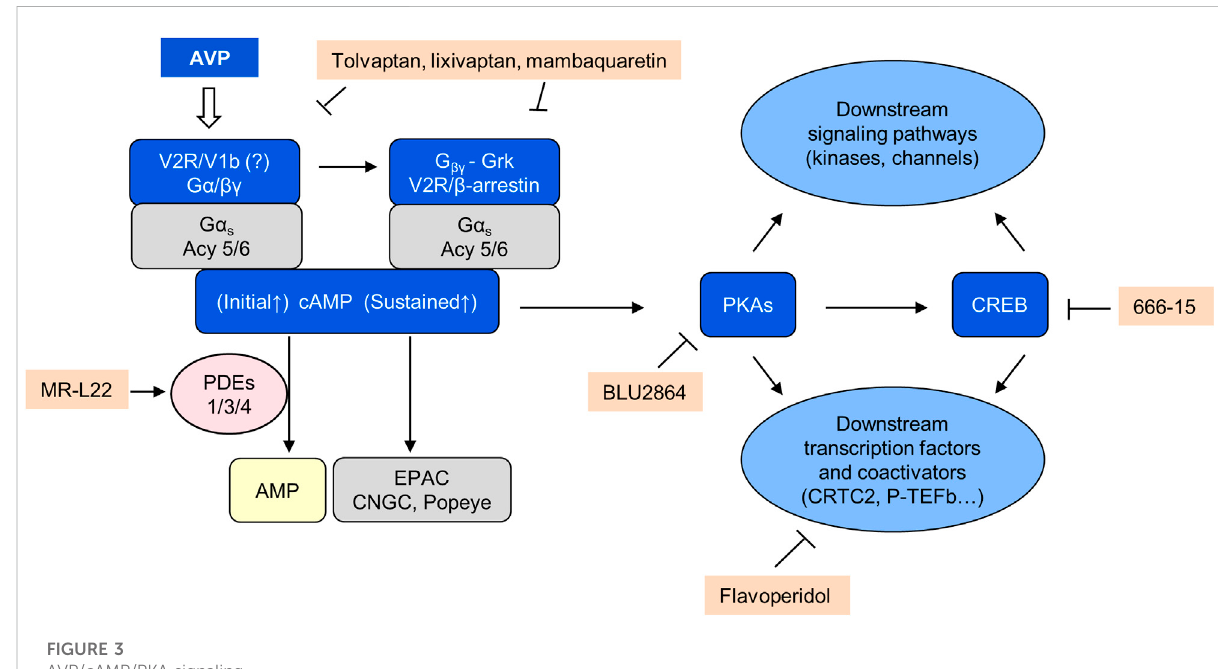
FIGURE 3 AVP/cAMP/PKA